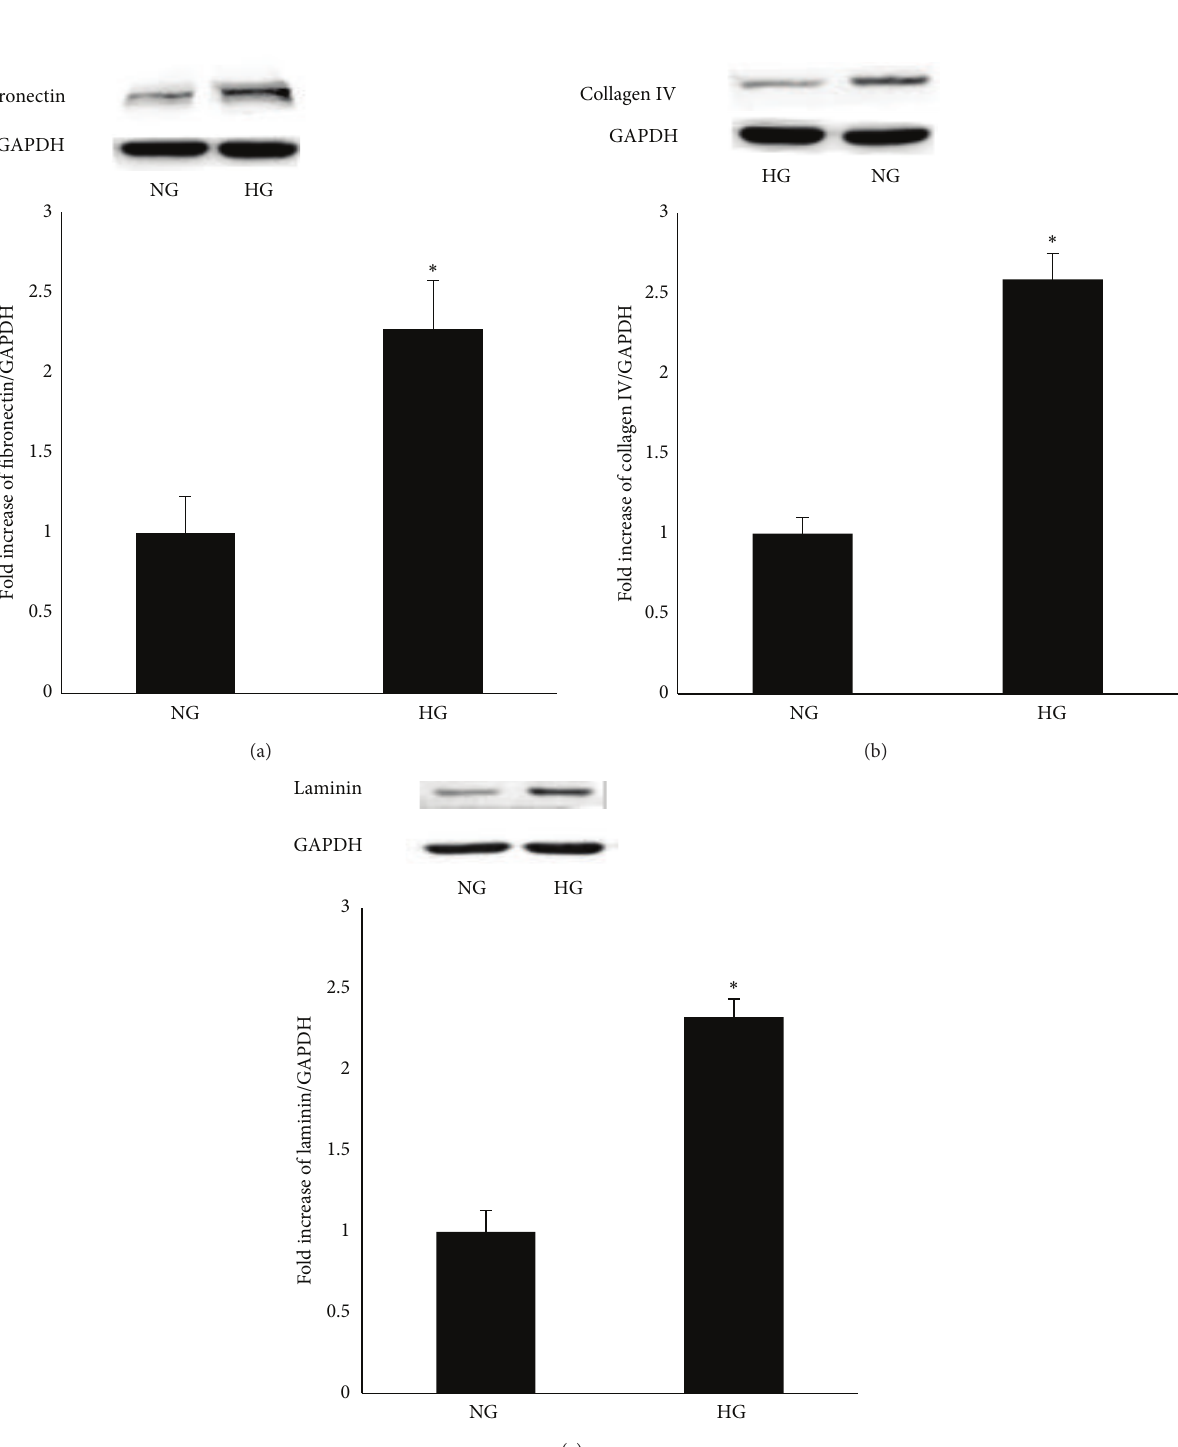
Figure 2: Effect of a high glucose concentration on the expression of fibronectin, collagen IV, and laminin protein in RPE cells. (a, b, c) A western blot analysis demonstrated that the protein expression of fibronectin, collagen IV, and laminin was upregulated when exposed to high glucose conditions for 24 h in RPE cells. NG and HG represent the normal glucose group and the high glucose group. The data represent the mean ± SD of three independent experiments. ∗ 𝑃 < 0.01 versus